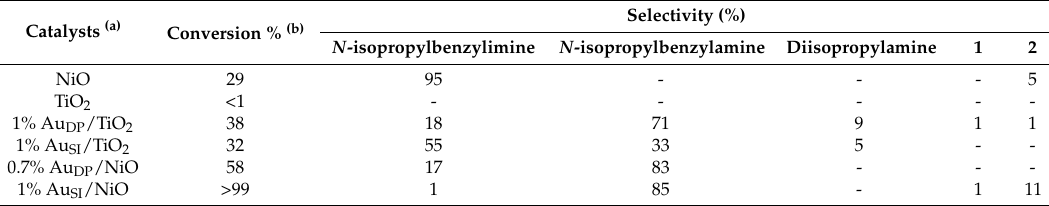
Table 2. Activity and selectivity of Au DP and Au SI based catalysts for the reductive amination of benzyl alcohol with isopropylamine.